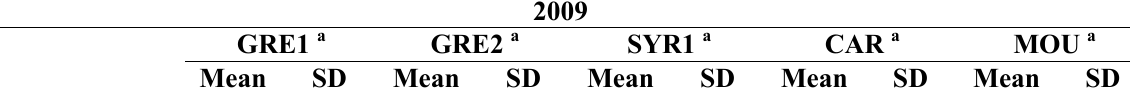
Table 5. Radical scavenging capacity of grape pomace skins and seeds in